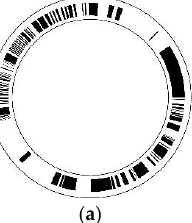
Figure 2. Disc pattern and reading head distribution of absolute encoder using a length-11 period-2046 STGC. ( a ) Schematic of the coding disc, where the white area indicates “0”, and the black area indicates “1”; ( b ) Schematic of the reading disc, where the 11 small circles denote the 11 reading heads and are evenly distributed around the coding track.